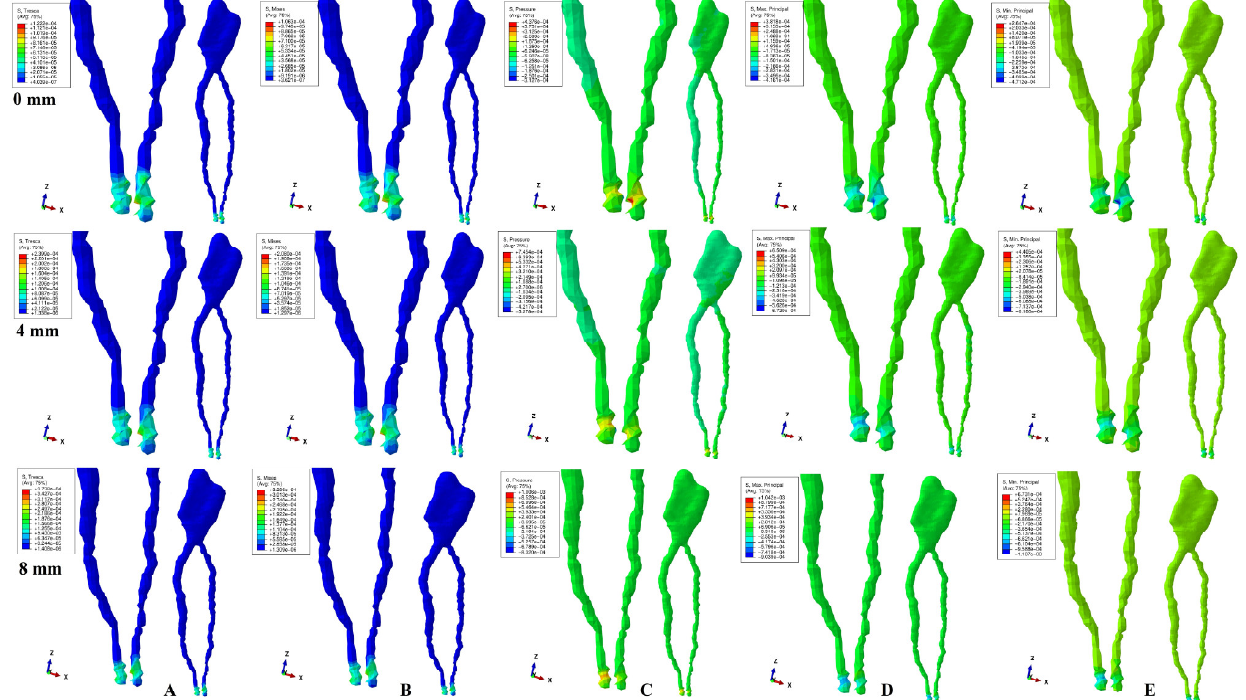
Figure 5. Stress distribution produced by tipping movement in the apical NVB and dental pulp of one of the nine models (intact, 4 mm and 8 mm reduced periodontium, vestibular-mesial view) in MPa: ( A )—Tresca, ( B )—Von Mises, ( C )—Pressure, ( D )—Maximum principal, ( E )—Minimum